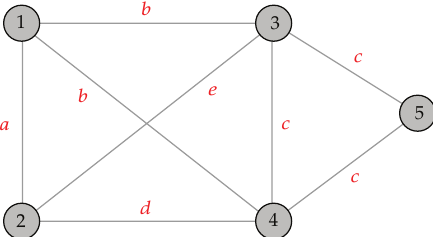
Figure 6: Example graph used in the following to show the properties of the formulations listed in Table 1. The set of labels is given by L (cid:6) { a,b,c,d,e } , the optimal solution value is f (cid:6) 3.